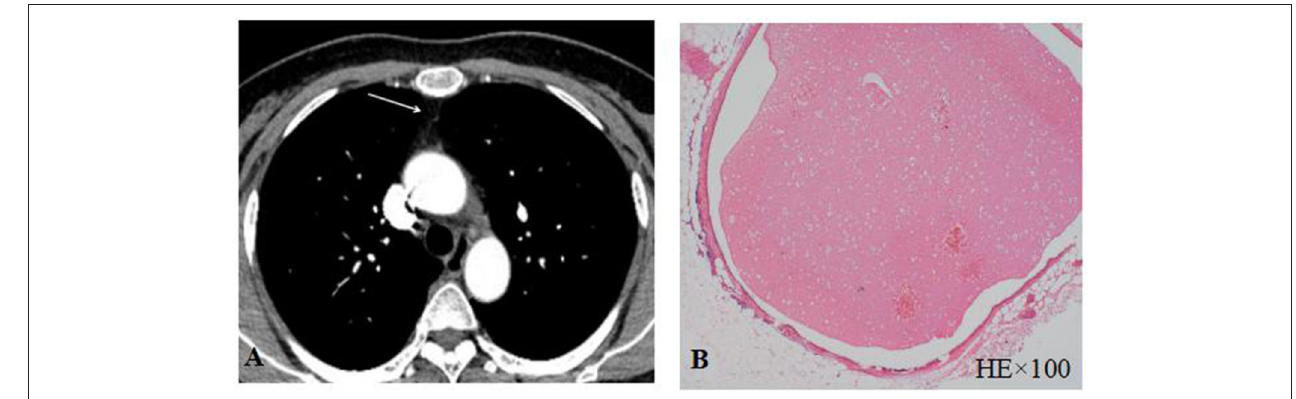
FIGURE 3 | (A) Thymus CT scan revealed a small nodule in the thymus area; (B) thymic bronchogenic cyst was shown by HE